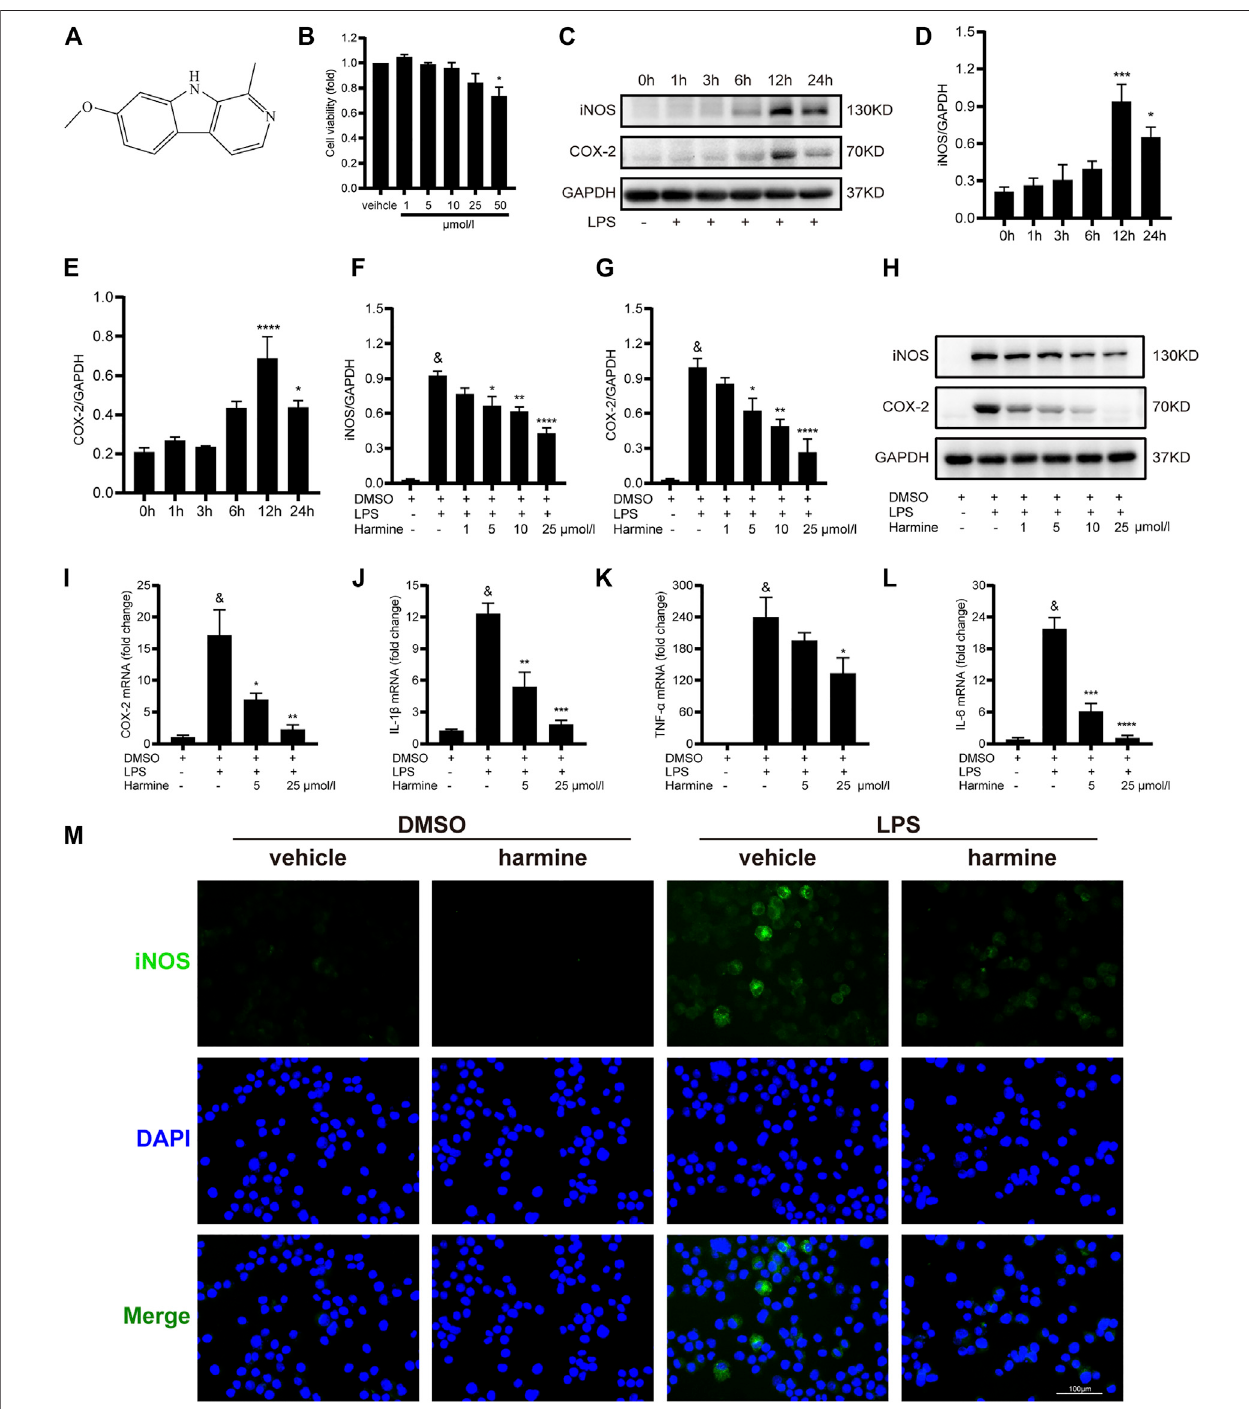
FIGURE 1 | Harmine inhibited M1 macrophage polarization in a dose-dependent manner. (A) Chemical structure of harmine. (B) Viability of RAW 264.7 cells after harmine treatment for 12 h ( n (cid:1) 3 independent experiments with six replicates). (C – E) Expression of the iNOS ( n (cid:1) 5) and COX-2 proteins detected ( n (cid:1) 4) after LPS stimulationfordifferentperiods(1,3,6,12,or24 h). (F – H) ExpressionoftheiNOS( n (cid:1) 4)andCOX-2proteins( n (cid:1) 4).RAW264.7cellswerepretreatedwithharmine(1,5, 10, or 25 μ mol/L) for 1 h and then challenged with LPS (1 μ g/ml) for 12 h (I – L) The relative expression of the COX-2, TNF- α , IL-1 β , and IL-6 mRNAs. RAW 264.7 cellswerepretreatedwithharmine(5and25 μ mol/L)for1 handthenstimulatedwithLPS(1 μ g/ml)for12 h. (M) Immuno fl uorescencestainingforiNOS(green)andDAPI (blue) ( n (cid:1) 3, 200X, scale bar: 100 μ m). RAW 264.7 cells were pretreated with harmine (25 μ mol/L) for 1 h and then stimulated with LPS (1 μ g/ml) for 12 h. GAPDH was applied asaninternalcontrolforwesternblottingandquantitativeRT – PCR.Dataareshownasthemeans ± SEM, & p < 0.05comparedwiththecontrolgroup;* p < 0.05, ** p < 0.01, *** p < 0.001, and **** p < 0.0001 compared with the LPS group.